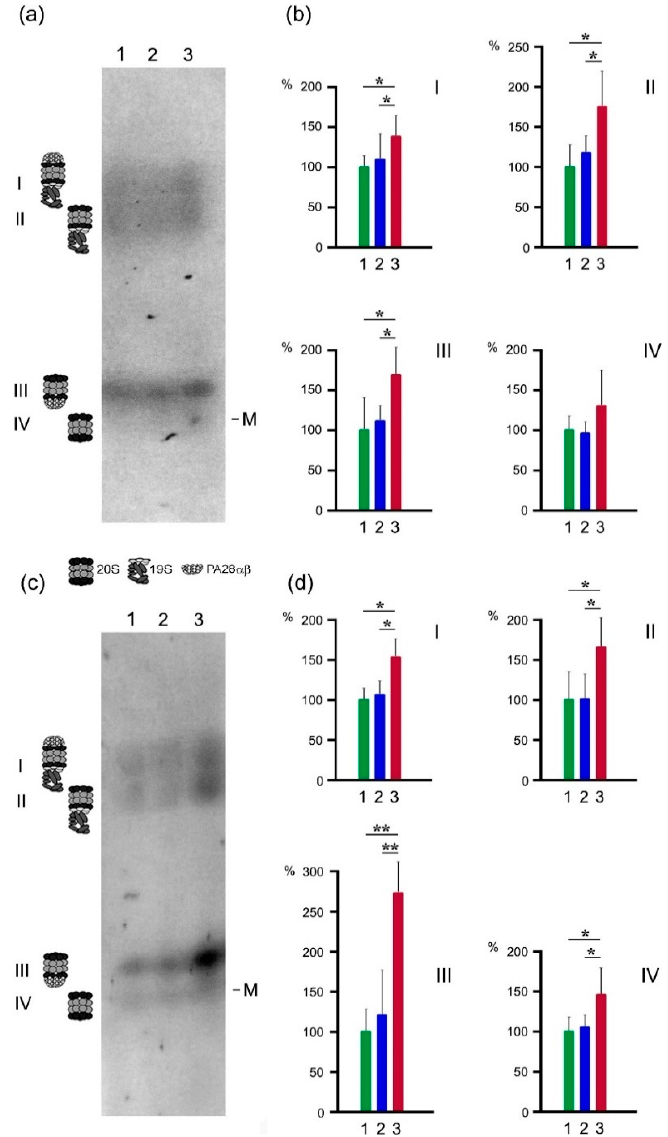
Figure 4. CL and LMP2 activities of proteasome subtypes in rectal adenocarcinoma and different intestine parts of patients. ( a ) CL activity in native PAG. ( b ) Relative CL activity for every gel zone. ( c ) LMP2 activity in native PAG. ( d ) Relative LMP2 activity for every gel zone. Thyroglobulin (670 kDa), labeled by dye Cy-3.5, was used as a marker (M) of molecular mass. Proteasome activity in intestine distal side in 2 cm from the tumor (taken as 100%) (1) and proximal side in 15 cm from the tumor (2) and tumor (3). Standard deviation is shown, p < 0.05 (*), p < 0.005